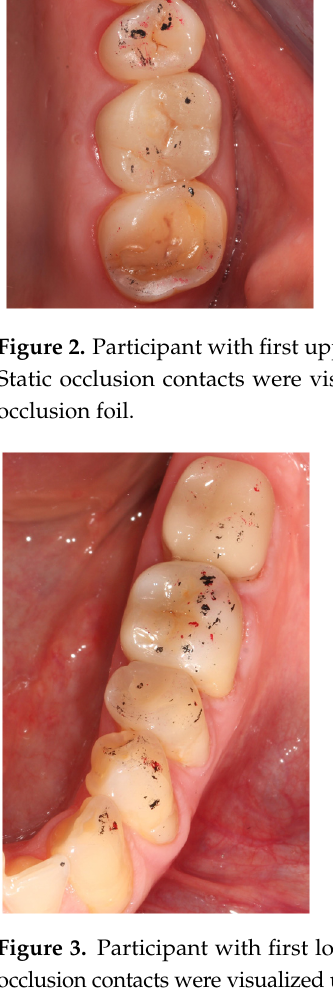
Table 2. Tooth- and restoration-related events in study groups. LiDi: lithium disilicate, Z: zirconia, SC: single crown, SB: sleep bruxism.